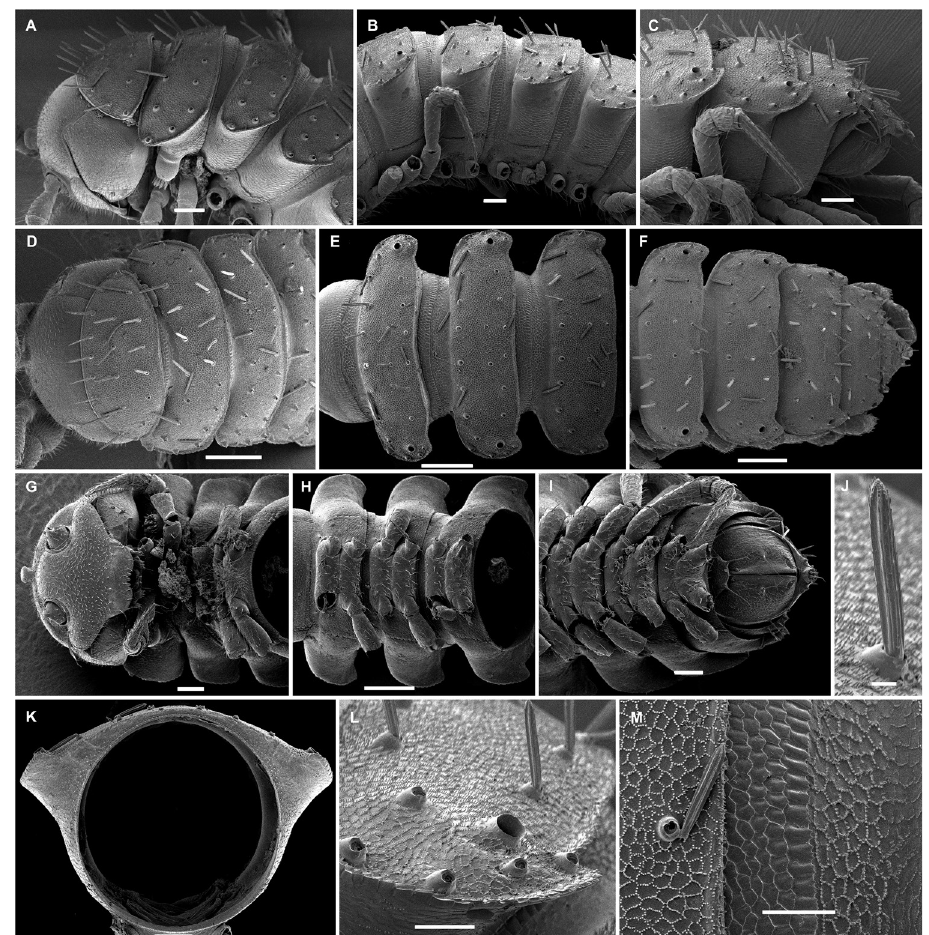
Figure 5. Hemisphaeroparia bangoulap sp. n., SEM micrographs of ♂ paratype A, D, G anterior part of body, lateral, dorsal and ventral views, respectively B, E, H midbody segments, lateral, dorsal and ventral views, respectively C, F, I posterior part of body, lateral, dorsal and ventral views, respectively J tergal seta, lateral view K midbody segment, caudal view L midbody paratergum, lateral view M tergal fine structure. Scale bars: 0.2 mm ( D–F, H ), 0.1 mm ( A–C, G, I, K ), 0.05 ( L, M ), 0.01 mm ( J